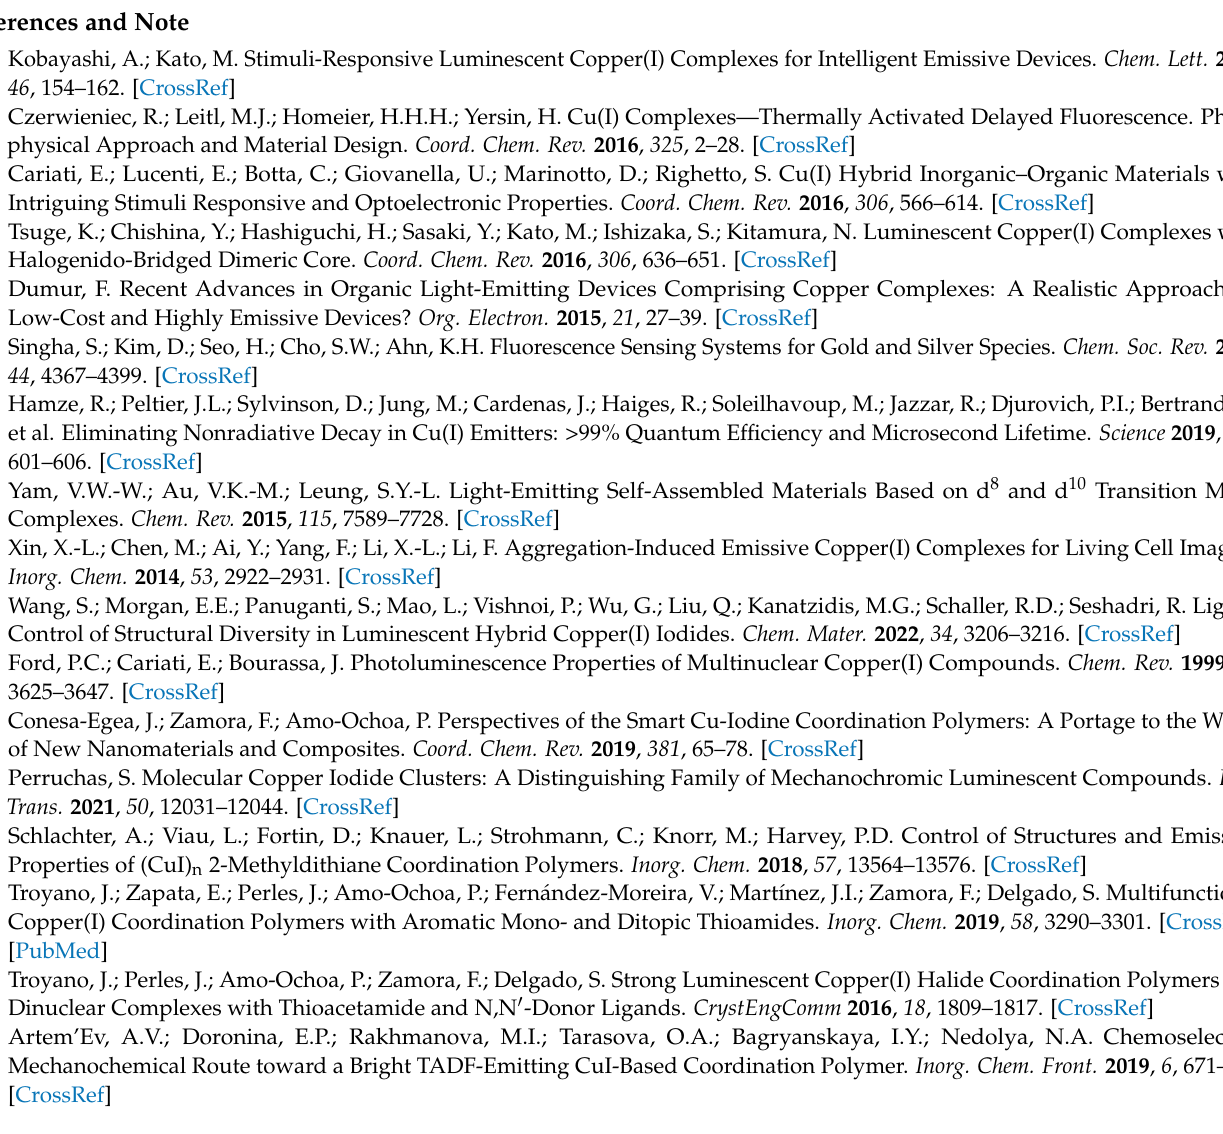
Table S3: Selected optimized bond distances for the model compound; Tables S4 and S5: Computed transitions for the model